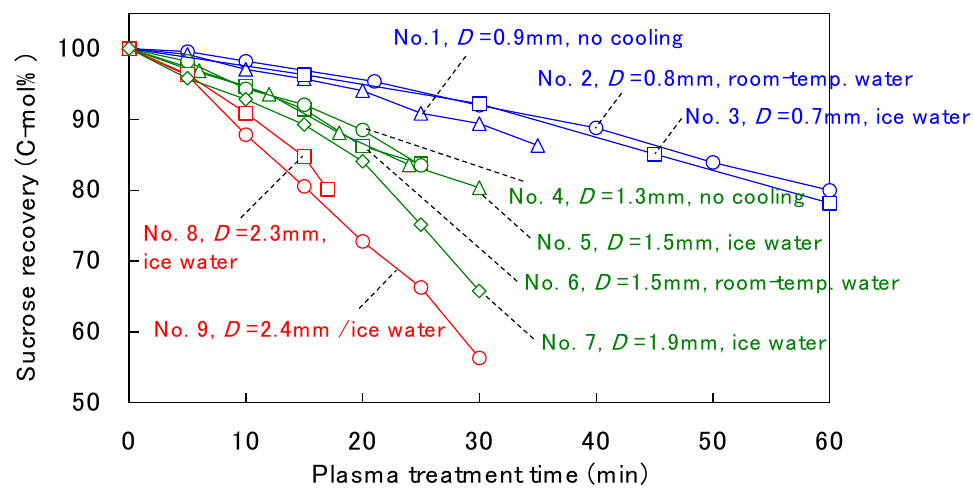
Figure 3. Sucrose recovery after solution-plasma treatment of sucrose (10 g/L) for various electrode distances, D , and cooling methods. Table 2. Product gas yields after solution-plasma treatment of sucrose (10 g/L) under the same conditions as those in Figure 3.